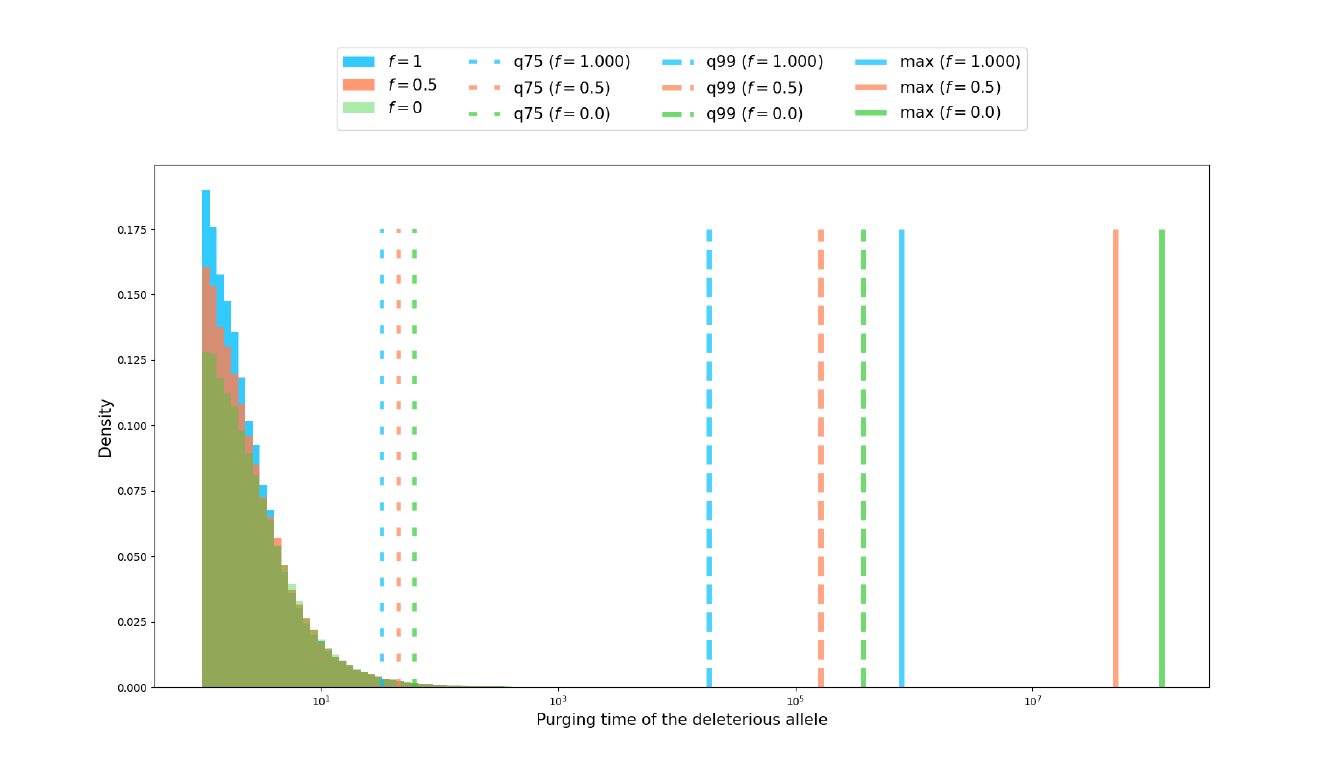
Figure S5 – Empirical distribution of the deleterious allele purging time for the partial dominance scenario. A total of 100,000 simulations were run, with s = 0.1 , h = 0.1 , r = 0.1 , p in = 0.5 , starting from one heterozygous individual ( X 0 = (1, 0, 0) ), and for three values of the selfing rate ( f = 0 in green, f = 0.5 in red and f = 1 in blue). The 0.0100 , ρ = 0.0157 and ρ = 0.0818 . The x-axis is respective values for ρ are ρ = − − − th log-scaled. The large-dotted lines represent the 75 percentile ( q75 ), the dashed lines th indicate the 99 percentile ( q99 ), and solid lines the maximum value ( max ) of the purging time. Maximum values are several order of magnitudes higher than the 75 th percentile of the empirical distribution of the purging